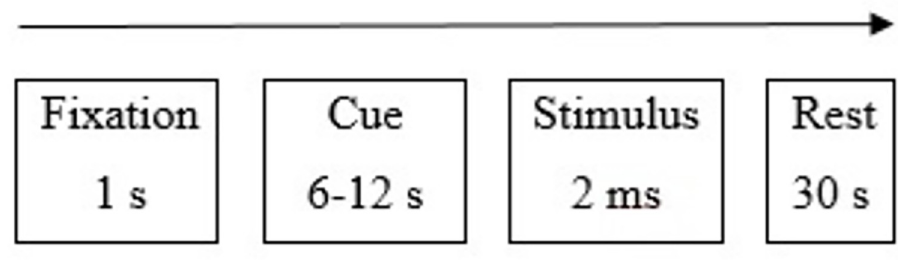
Fig 1. Design of the pain